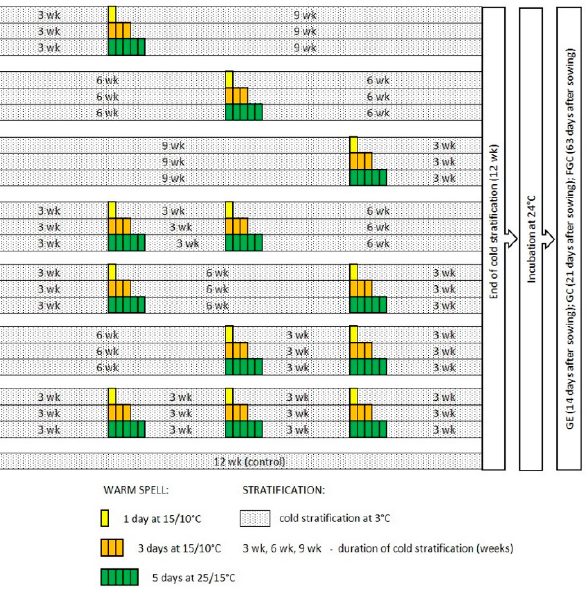
Figure 2. Schematic of treatments to examine the interruption of cold stratification by warm spells differing across time (week 3, 6 and/or 9), in lengths (1, 3 and 5 days) and in temperatures (15/10 °C and 25/15 °C). GE — germination energy; GC — germination capacity; FGC — final germination capacity; wk — duration of cold stratification (weeks). Concept of figure based on Flanigan et al. [10].